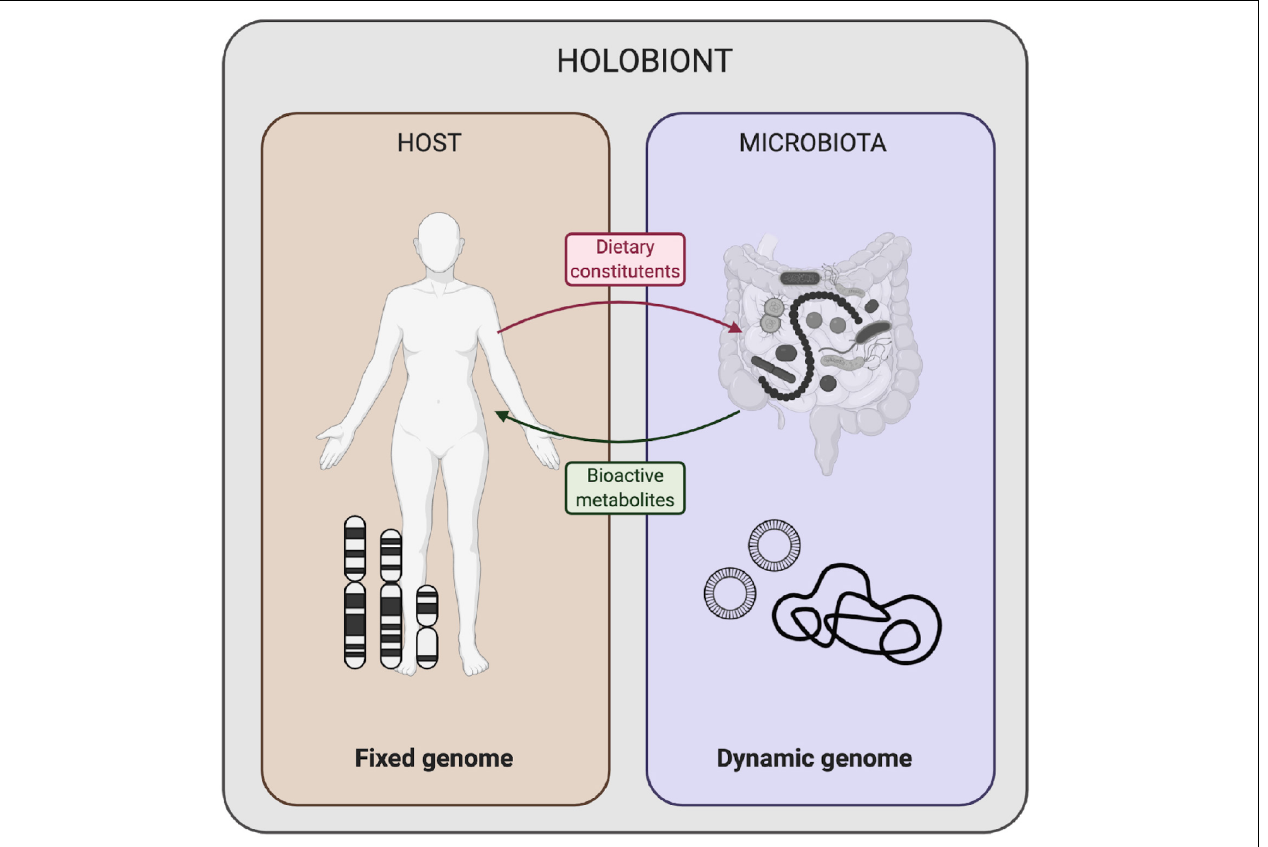
FIGURE 3 | The holobiont genome comprise of the human host genome (fixed at conception with limited accumulation of somatic mutations throughout life) and dynamic microbiome (amenable to change following dietary variations). Dietary intake and habits of the human host can determine the genomic configuration and transcriptional activity of the commensal gut microbiota that break down ingested foods to produce bioactive metabolites with a wide range of effects on the human host. Illustration was created with